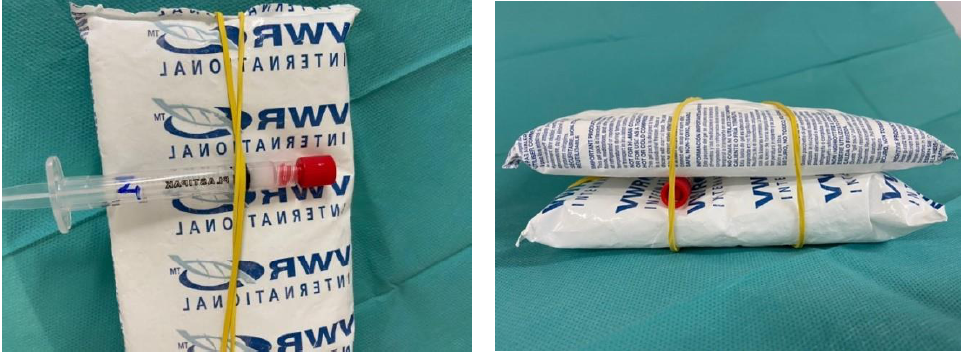
Figure 13. Steps to place syringe containing Vidaza ® suspension between two common refrigerant gel packs: step 1 ( left ) and step 2 ( right ).